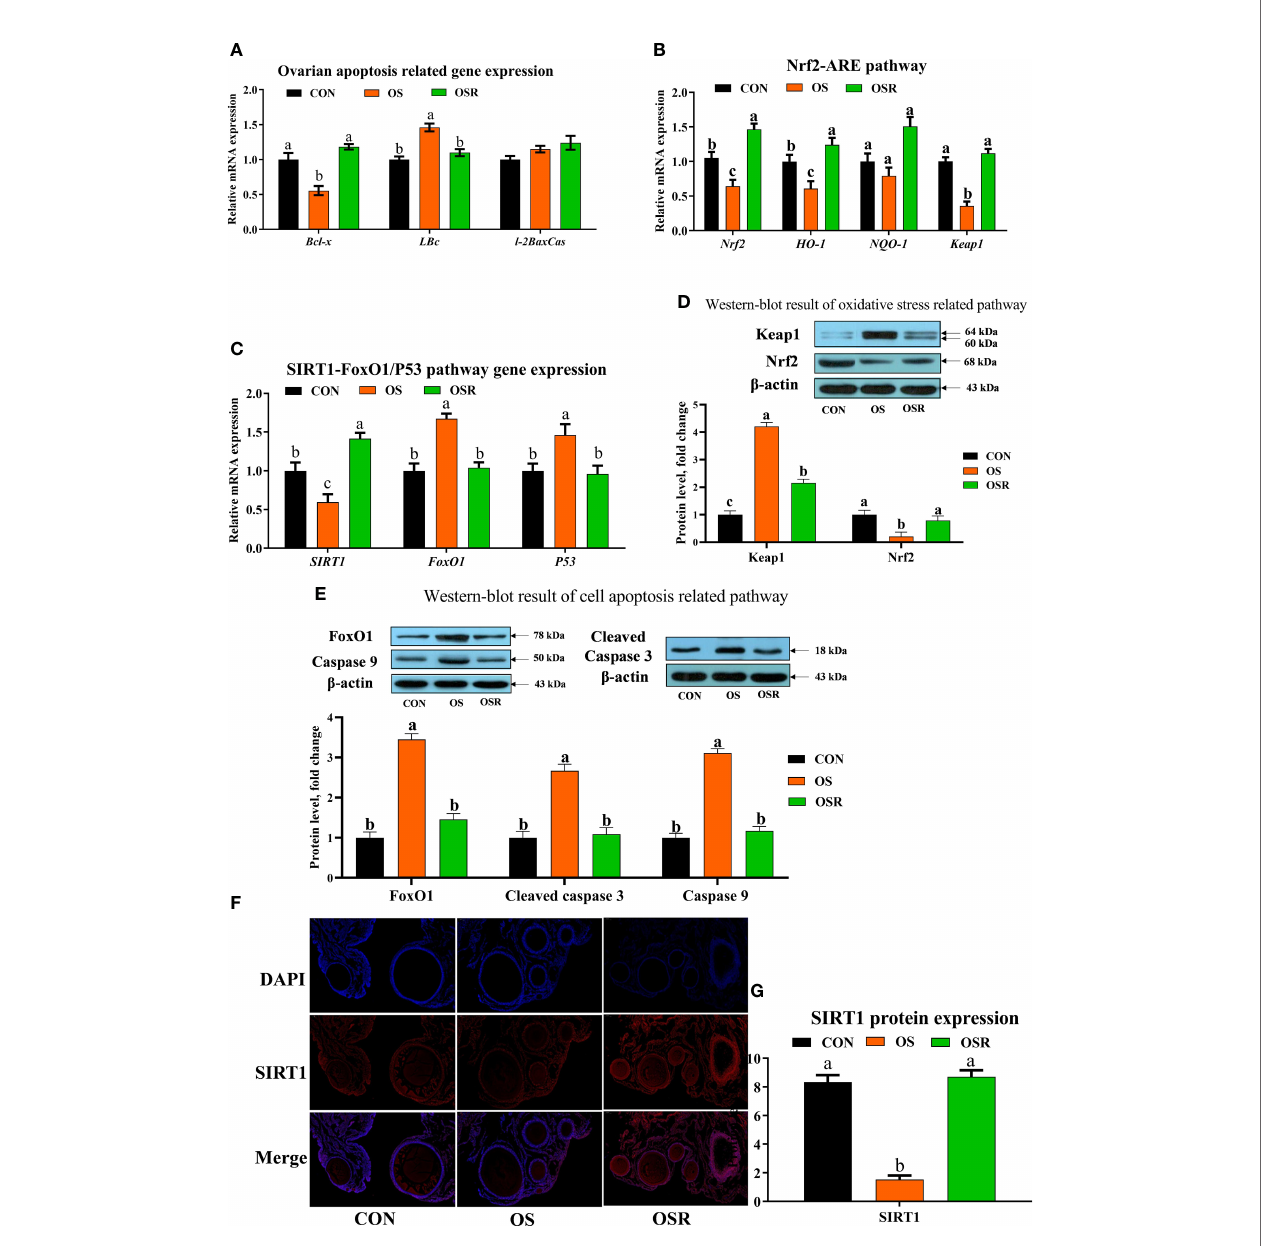
FIGURE 4 | Dietary resveratrol supplementation alleviated the oxidative stress (induced by tBHP) induced depression ovarian oxidative stress and apoptosis-related pathway (Exp. 1). (A) Ovarian apoptosis-related gene expression. (B) Oxidative stress-related pathway (Nrf2-ARE) gene expression. (C) SIRT1-FoxO1/P53 gene expression. (D) Western-blot result of cell apoptosis-related pathway. (F-G) The immuno fl uorescence results of SIRT1 protein. Data are plot individual values (n = 10). CON, control; OS, oxidative stress (injection of 800 m mol/kg BW of tBHP); OSR, CON + 600 mg/kg resveratrol; SIRT1, silent information regulator 1; FoxO1, forkhead Box O1; Nrf2, nuclear factor E2-related factor 2. Statistical signi fi cance was evaluated by Tukey ’ s Test, p <